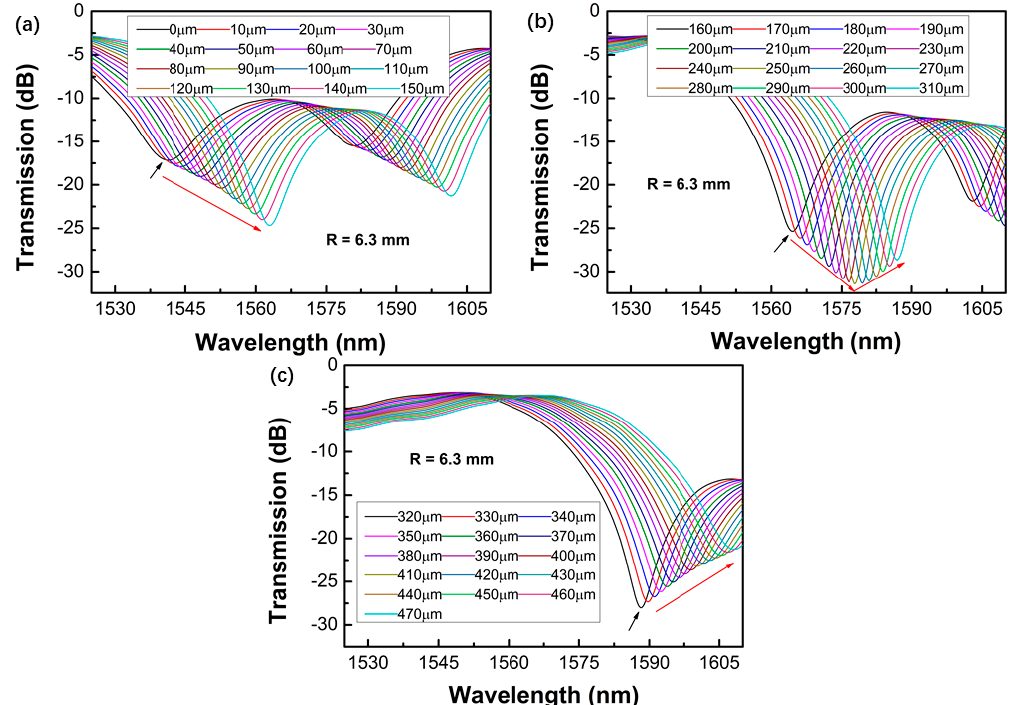
Figure 8. Transmission spectra of the proposed sensors varied with the displacement ranges of 0–150 μ m ( a ), 160–310 μ m ( b ), and 320–470 μ m ( c ) for the bending radius of 6.3 mm.